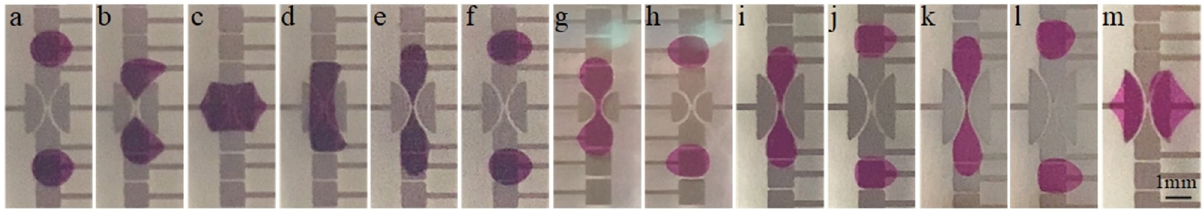
Figure 9: Series of video frames displaying the process of splitting a mother droplet into two child droplets using the optimized electrodes scheme; ( a – f ) The cutting electrodes radius R = 1.2 mm; ( g and h ) The cutting electrodes radius R = 0.7 mm; ( i and j ) The cutting electrodes radius R = 1.6 mm ( Video S3 ) ; ( k – m ) The cutting electrodes radius R = 2.0 mm ( Video S4 )